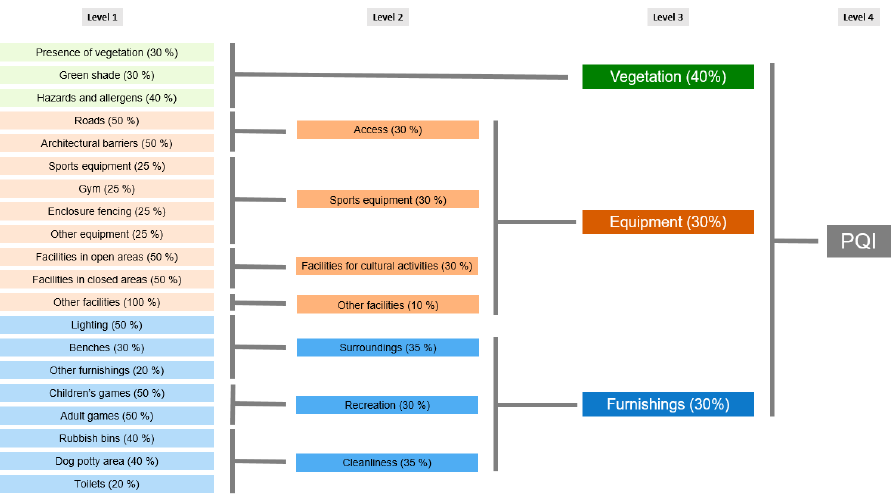
Figure 4. MCE of the quality of urban parks. Source: own work .